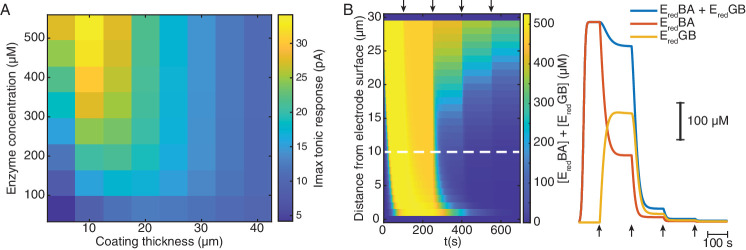
Mathematical simulation of ChOx-biosensor tonic responses and reduced enzyme-bound intermediate dynamics.(A) Maximal cumulative tonic sensor responses as a function of coating thickness and enzyme concentration in the coating. (B) Left shows simulated concentration dynamics of total reduced enzyme-bound intermediates (EredBA+EredGB) in the sensor coating as a function of distance from the electrode surface during a simulated calibration of a high enzyme-loaded sensor (coating thickness of 30 μm and enzyme concentration of 560 μM). Right shows the dynamics of total and individual enzyme-bound intermediates at 10 μm from the electrode surface (dashed line in left panel). Arrows indicate 5 μM O2 step increments in solution.